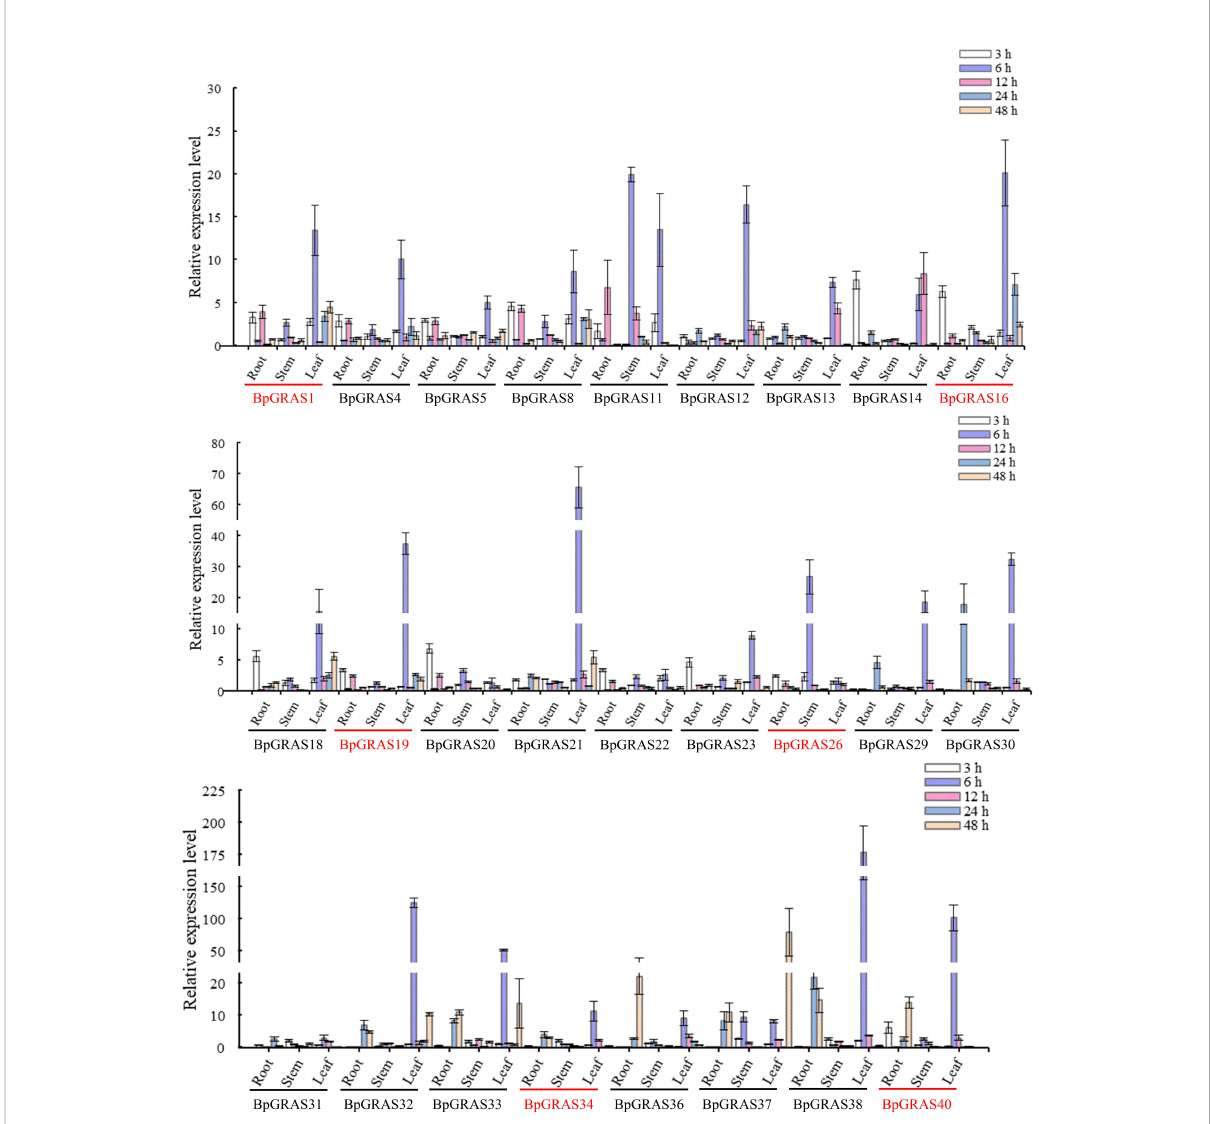
FIGURE 4 Expression analysis of selected BpGRASs using RT-qPCR. The expression patterns of BpGRASs in the roots, stems, or leaves of birch plants in response to treatment with NaCl (200 mM). The expression of BpGRASs under normal conditions (0 h) was designated as 1, in order to standardize the expression level of BpGRASs under salt stress conditions. Three independent experiments were performed, and data are means ± SD from the three experiments. Six BpGRASs selected for further analysis were emphasized with red